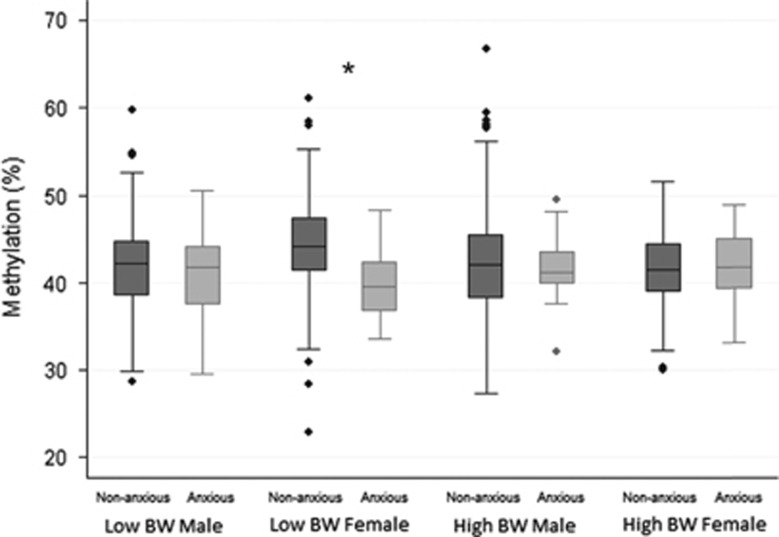
Population distribution of IGF2/H19 ICR DMR methylation levels in non-anxious and anxious groups, stratified by both infant sex and birth weight. *P=0.0001. BW, birth weight; DMR, differentially methylated region; ICR, imprinting control region.